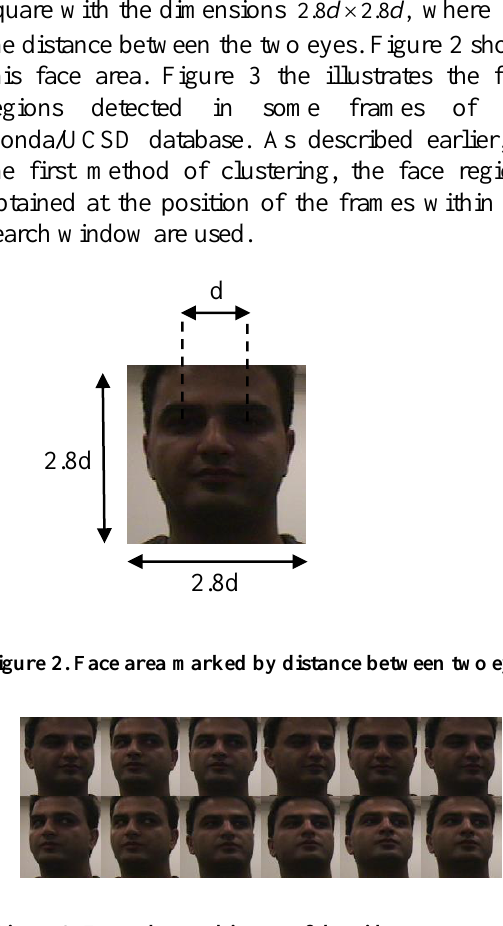
Figure 3. Faces detected in one of the video sequences of Honda/UCSD database.